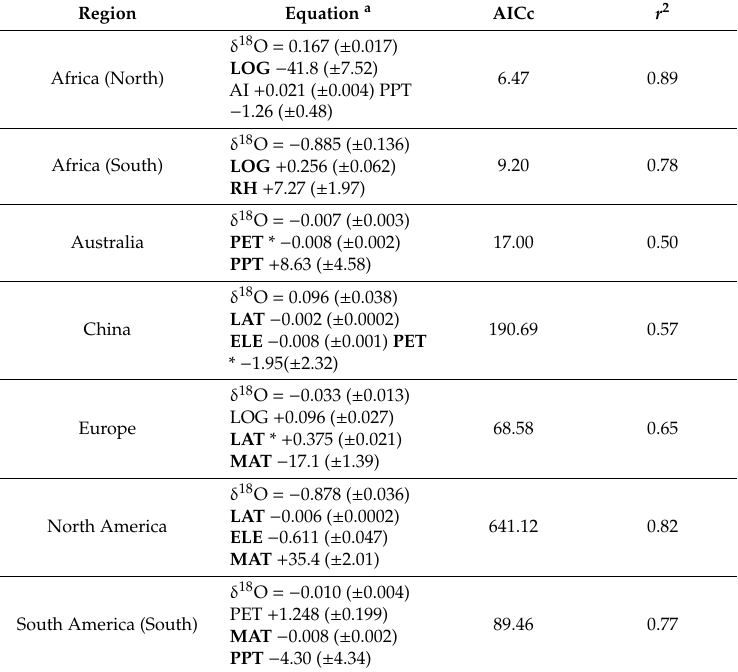
Table 4. Summary of the result of regression models. The equation, AICc and r 2 of the best regression models of each regions are listed in the table. The bold font represents the behavioral variable which is defined as being used in more than 3 of the 5 top regression